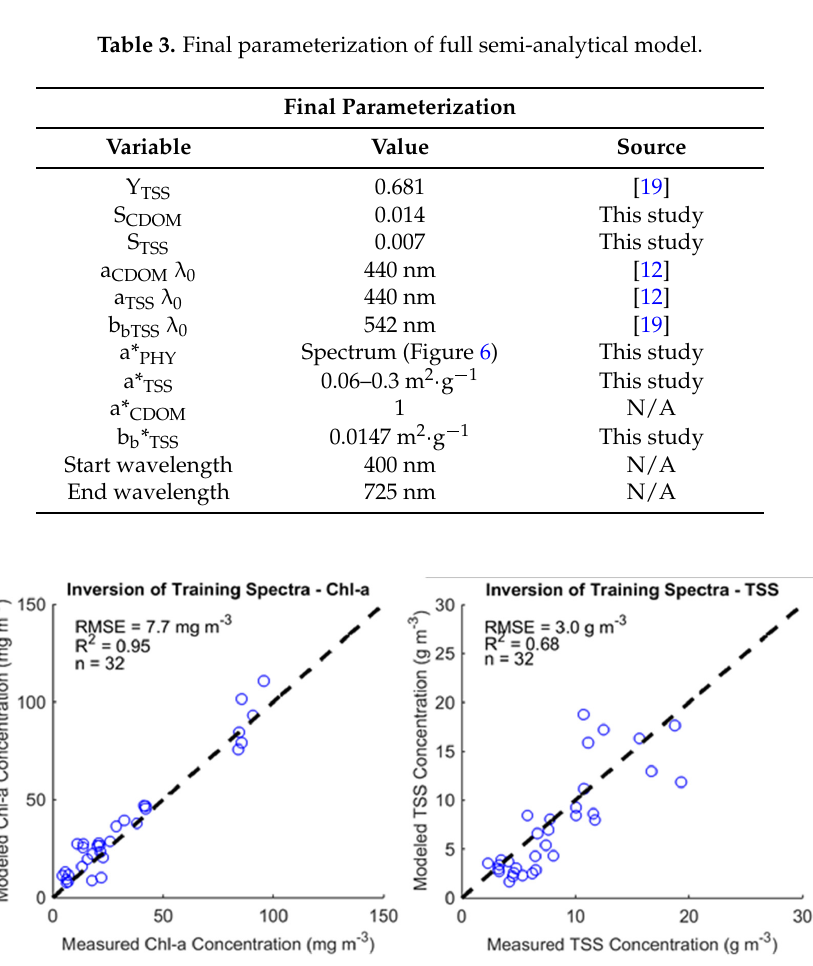
Figure 7. Results from the inversion of training spectra to obtain chl-a and TSS concentrations. The dotted black line indicates 1:1 correspondence. n is the number of samples displayed. R 2 is the coefficient of determination calculated for each sub-plot data.